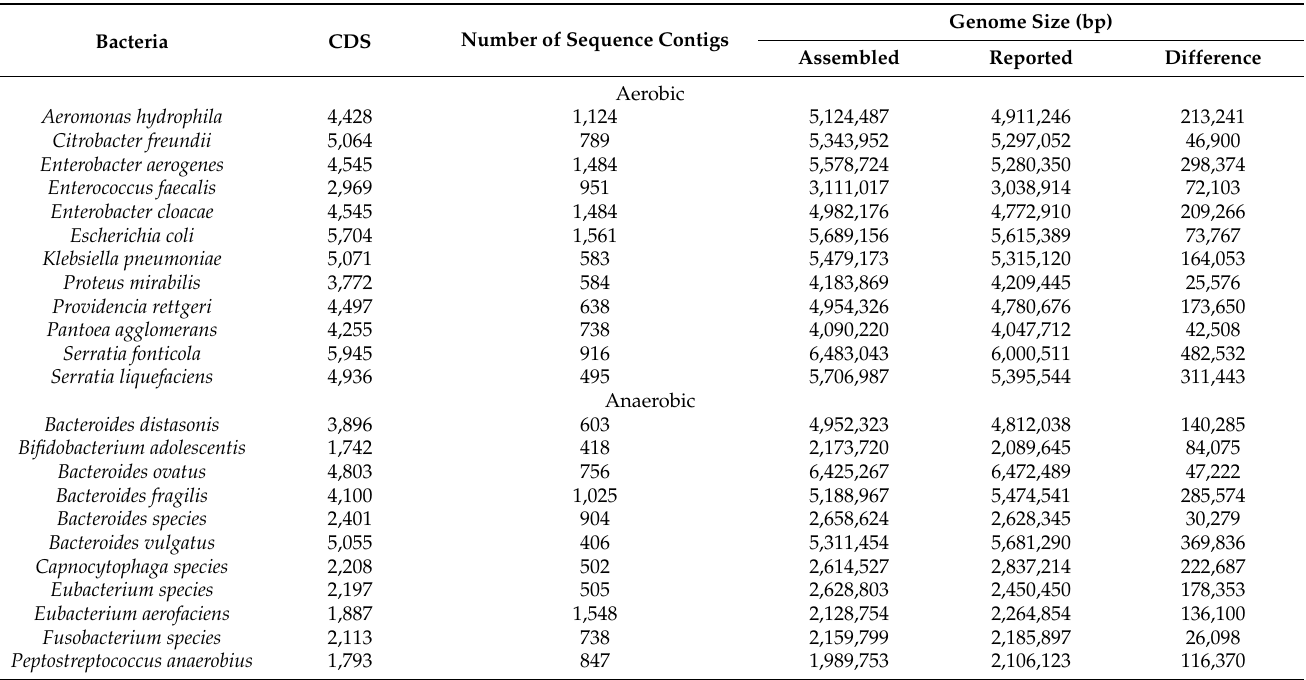
Table 2. Whole-genome sequencing characteristics of aerobic and anaerobic Enterobacteriaceae rods isolated from human feces in healthy conditions.